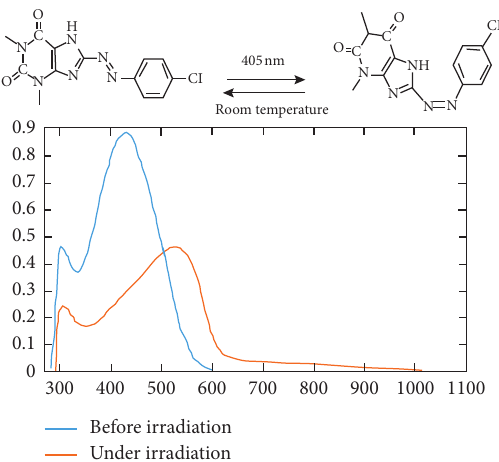
Figure 5: UV-visible absorption spectra of CPAT before (blue line) and under irradiation (red line) at 405nm in acetone.